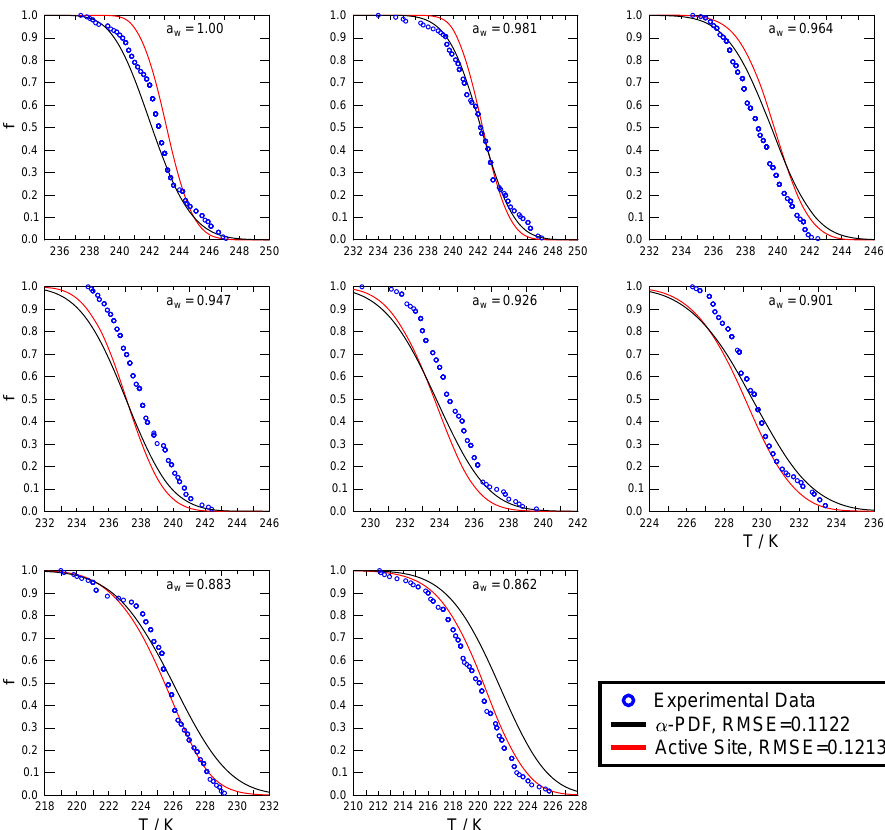
Fig. 7. Resulting immersion freezing descriptions for water and aqueous ( NH 4 ) 2 SO 4 droplets containing Pahokee peat when fitting the entire immersion freezing data set including all investigated a w using α -PDF (black lines) and active sites parameterizations (red lines). The experimentally derived cumulative frozen fraction, f , of droplets in 0.2K temperature increments is represented by blue circles. The fit quality is given by the RMSE.